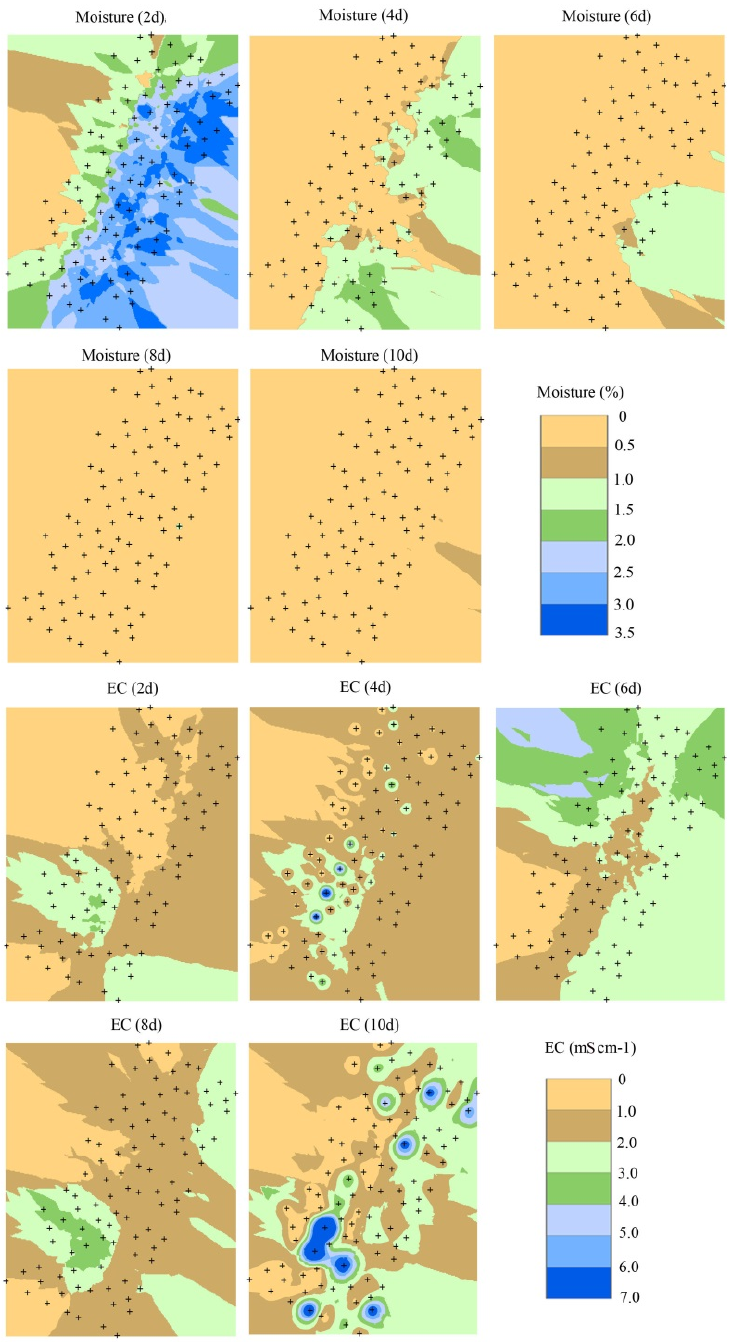
Figure 3. Ordinary Kriged maps of soil moisture and EC during the irrigation cycle in July. 2d, 4d, 6d, 8d, 10d represent 2nd, 4th, 6th, 8th, 10th days after